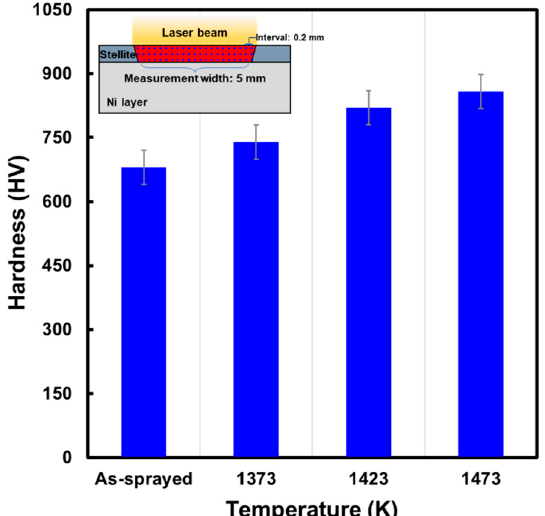
Figure 7. Relationship between laser heat treatment temperatures and the average hardness of Stellite- 1 coating.